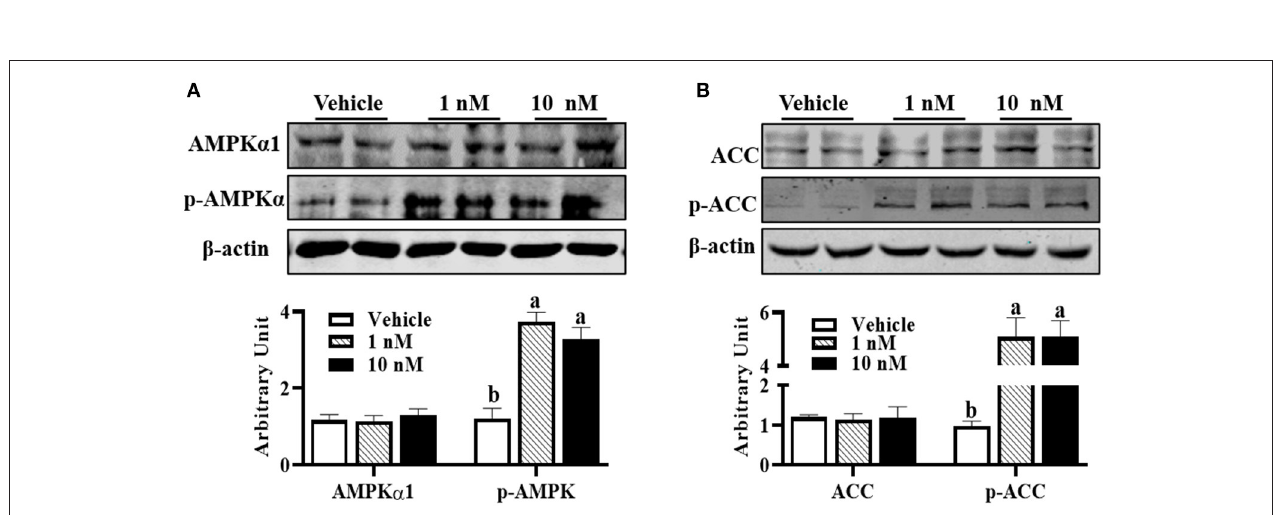
FIGURE 3 | Melatonin activated AMPK during precursor cell differentiation. Isolated precursor cells were treated with indicated concentrations of melatonin for 24h, and Western blot analysis was performed to analyze (A) AMPK α 1, p-AMPK α , (B) ACC, and p-ACC protein abundances ( n = 6, mean ± SEM; different letters mean significant